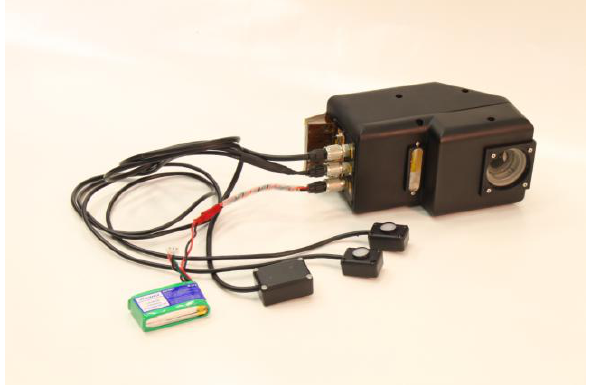
Figure 1. The FPI spectrometric imaging system including the camera, a 32 Gbyte compact flash memory card, two irradiance sensors, a GPS receiver and a LiPo battery